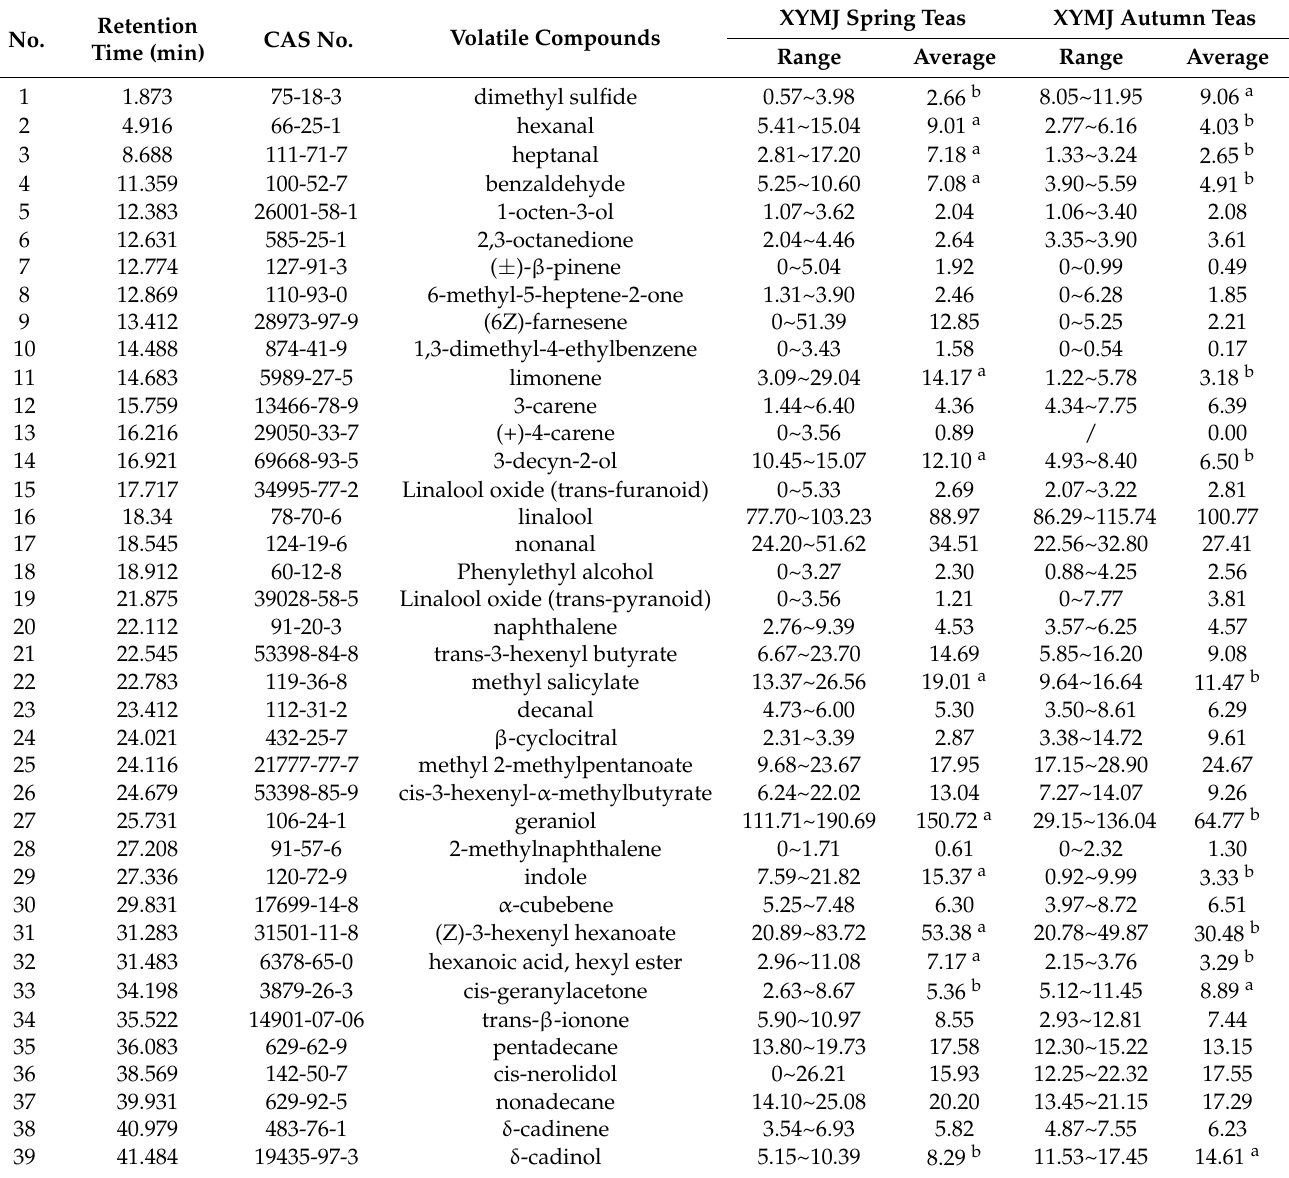
Table 2. Contents of volatile compounds tentatively identified in XYMJ green teas ( µ